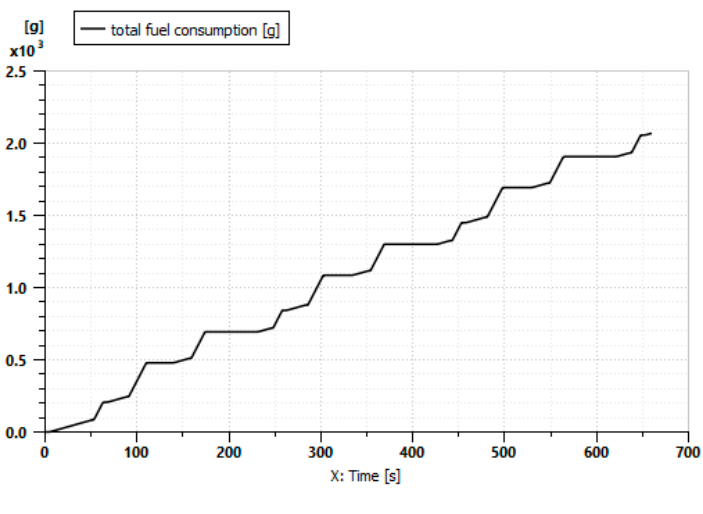
Figure 21. Fuel consumption.